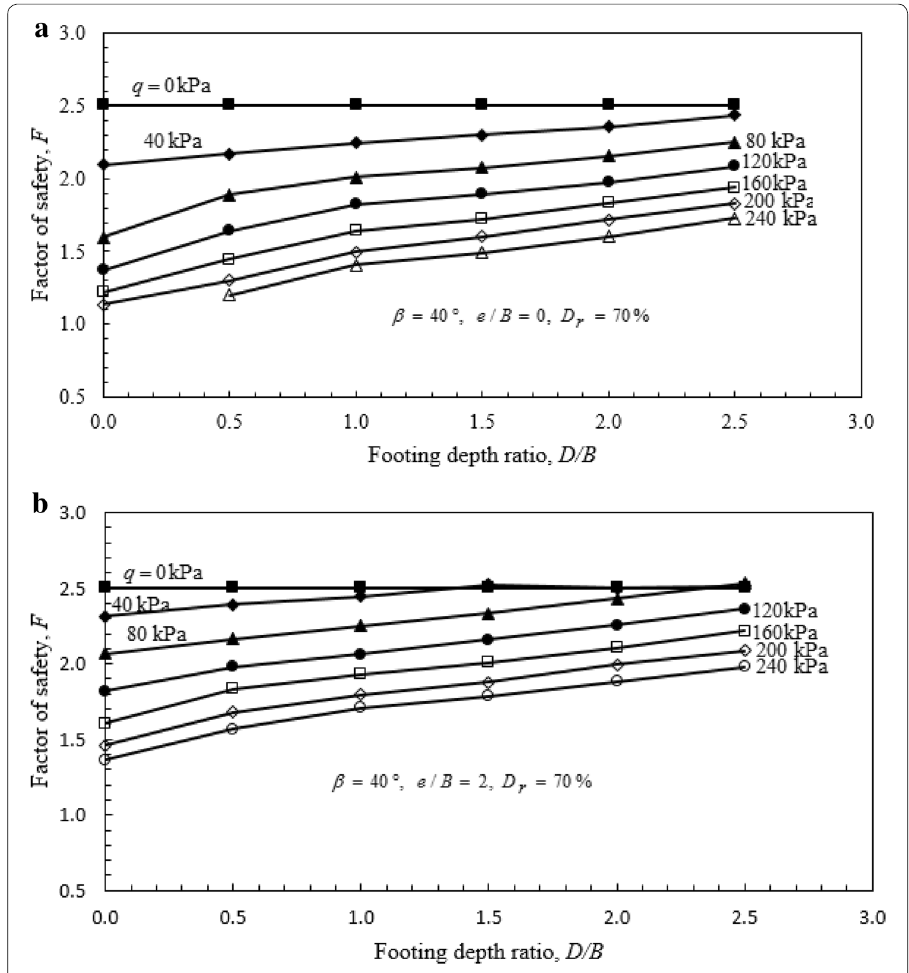
Fig. 6 Variation of factor of safety, F , with footing depth ratio D / B for 40° slope: a e / B = 0 , b e / B =